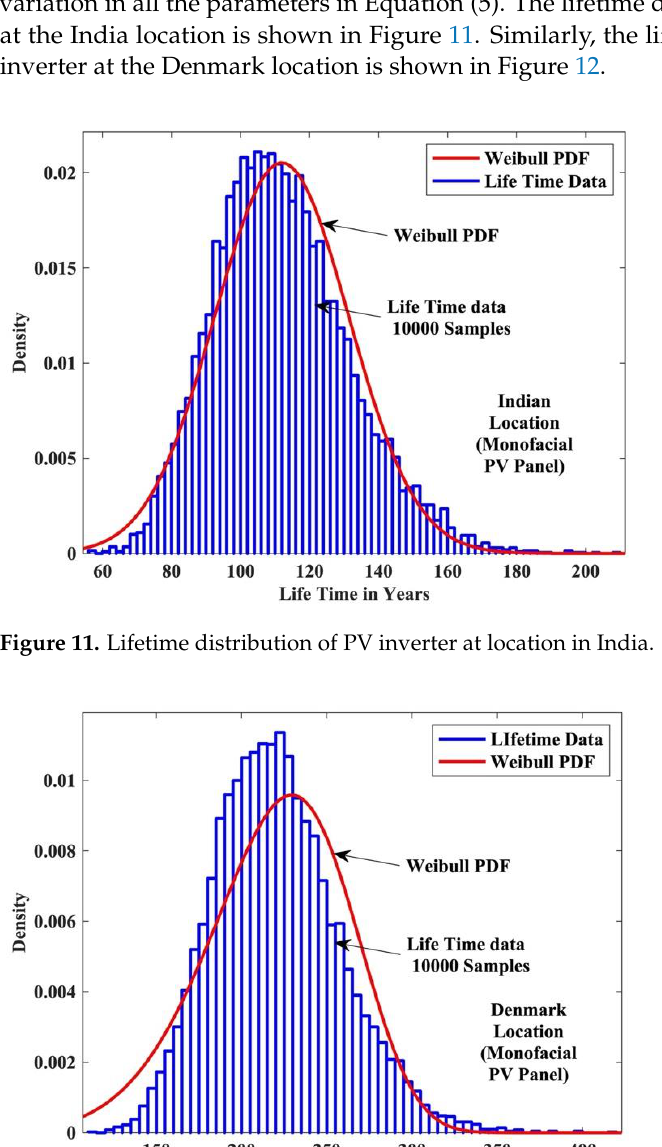
Table 3. Lifetime evaluation considering a monofacial PV panel.